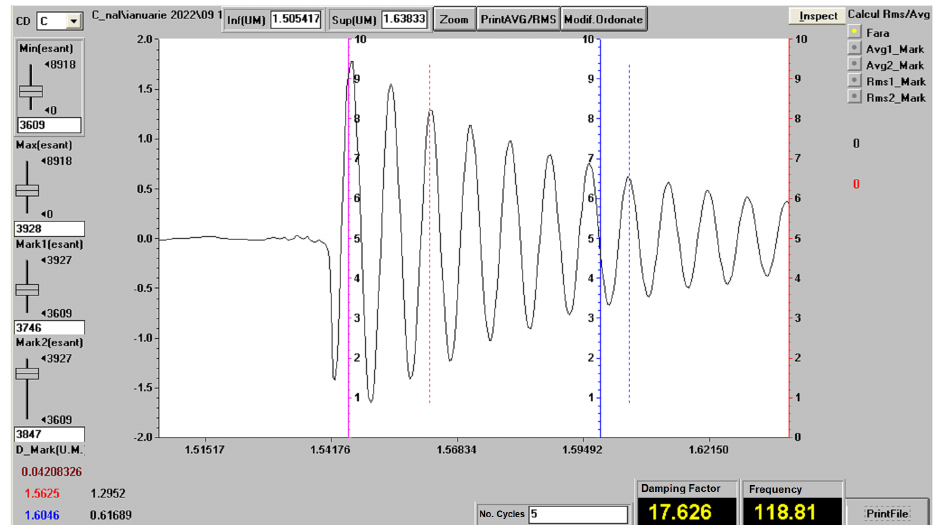
Figure 8. Determination of the frequency and damping factor for the test piece in the PTD7 set and the free length of 120 mm.